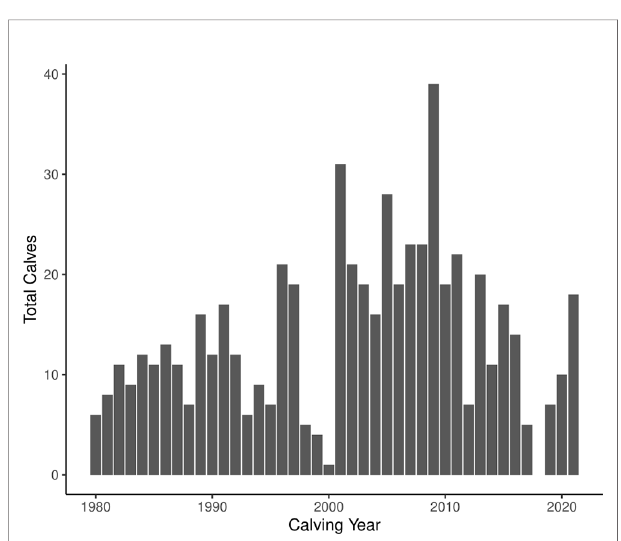
FIGURE 1 | Total number of observed right whale calves born each year since